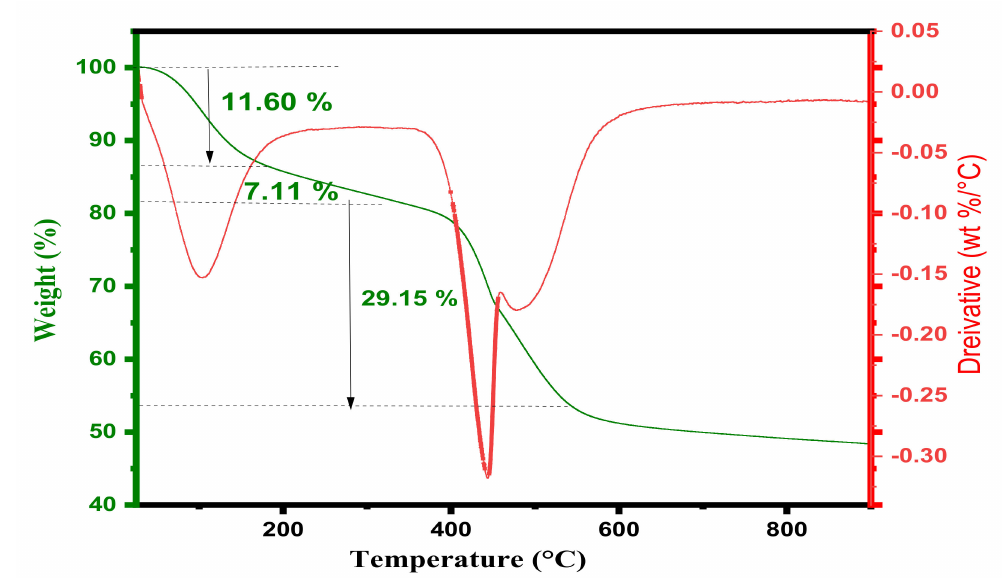
Figure 5. Parallel TGA-DTA curves of